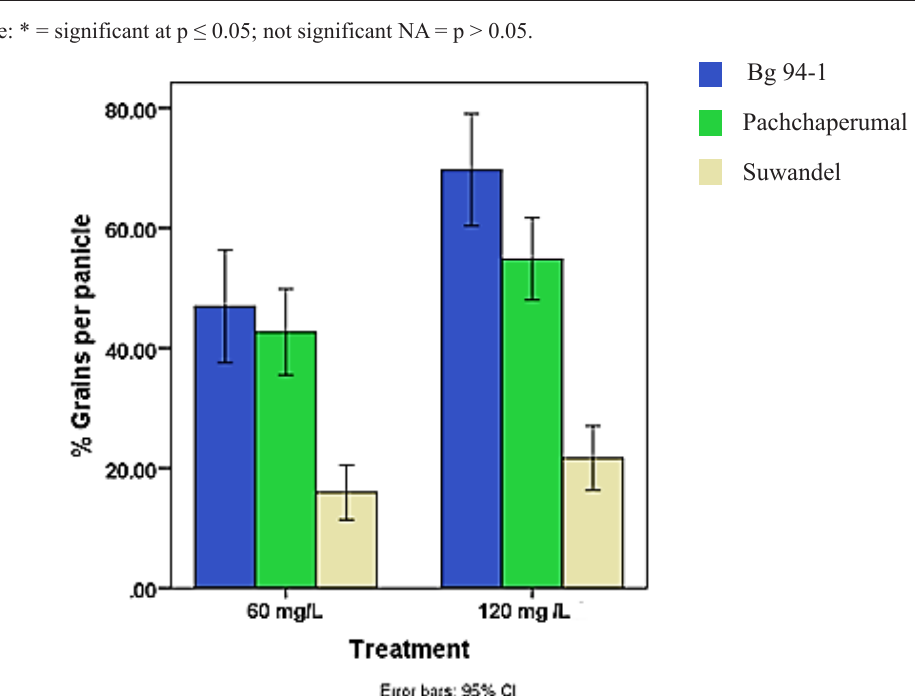
Figure 5: Variation of mean of percentage grains per panicle of rice varieties at the concentration of 60 mg L -1 of nano-ZnO and 120 mg L -1